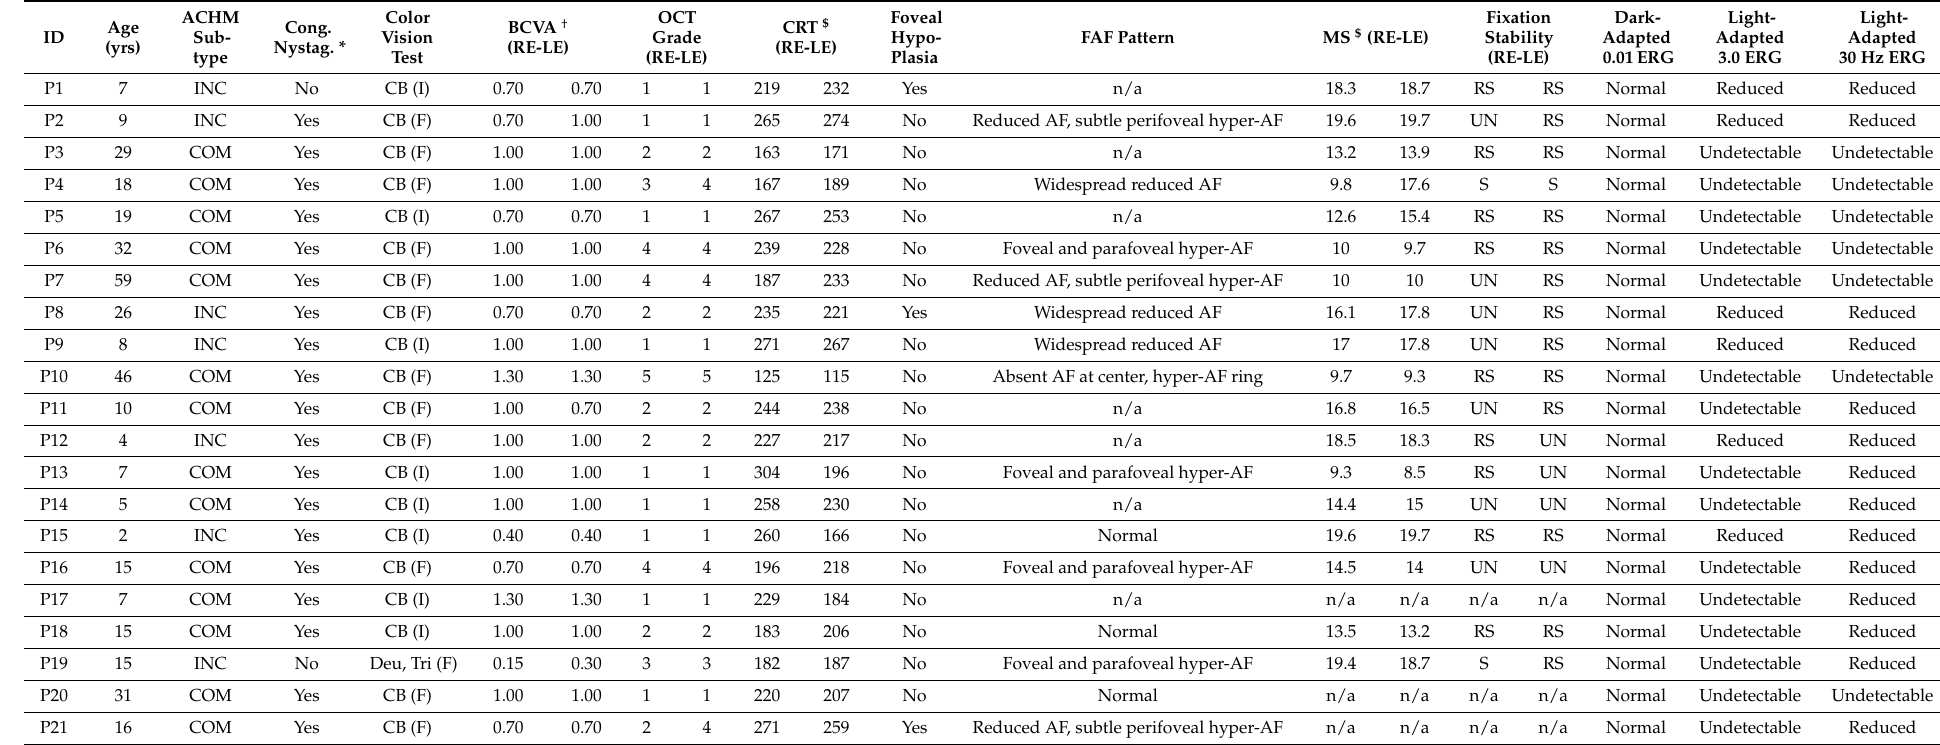
Table 1. Main clinical findings in each achromatopsia patient at the study